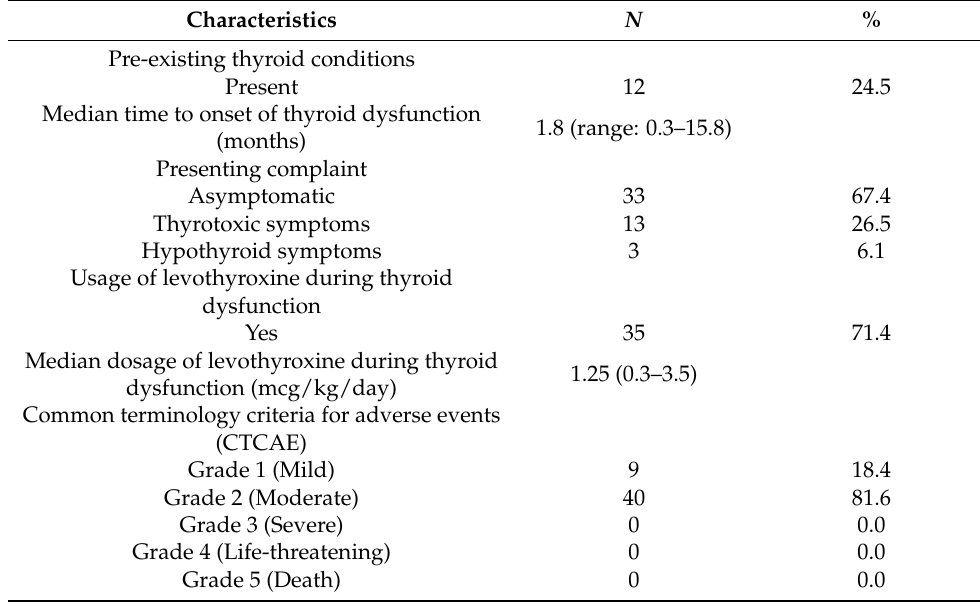
Table 2. Characterisation of patients with thyroid dysfunction ( n =